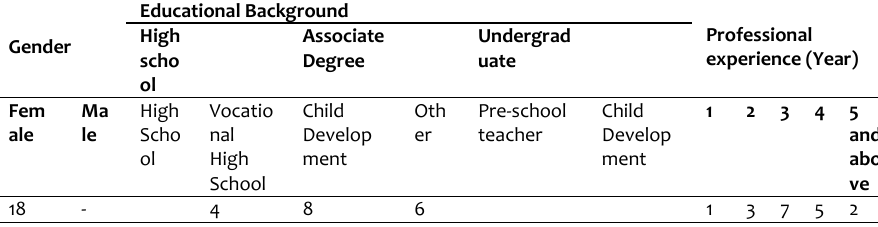
Table 1. Demographic Information of Teachers